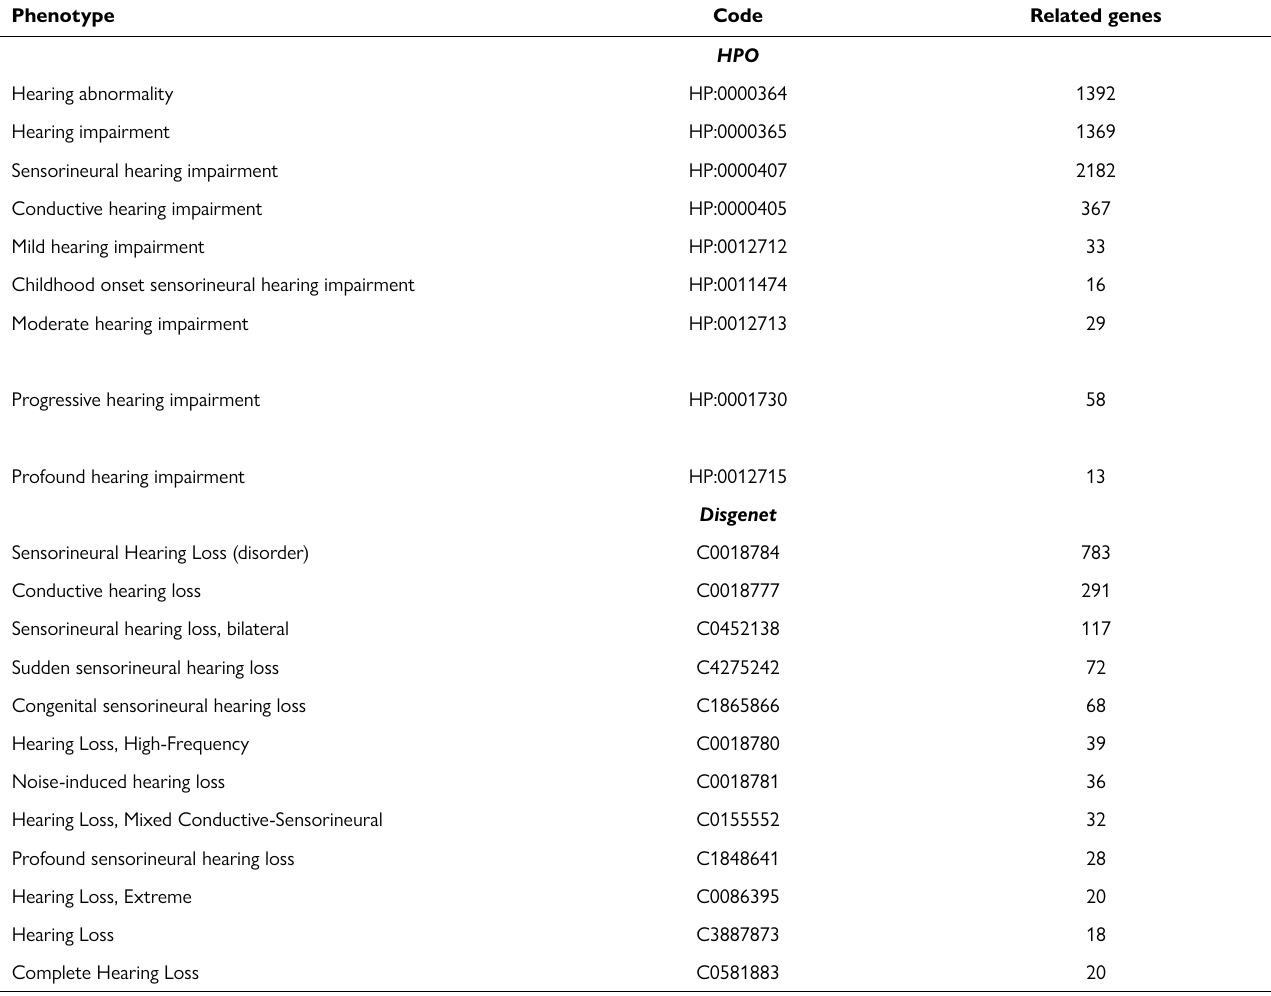
Table 1. Related terms and phenotypes used in the network